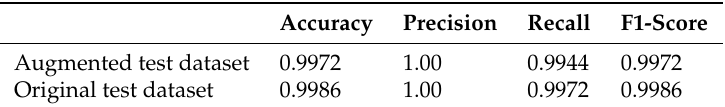
Our augmented test dataset is four times the original dataset. Therefore, there are 716 similar/homoglyph pairs and 716 dissimilar/non-homoglyph pairs. The augmented test dataset is originated from the original test